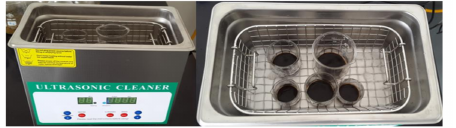
Figure 1. Removal of impurities from NPs by sonication.